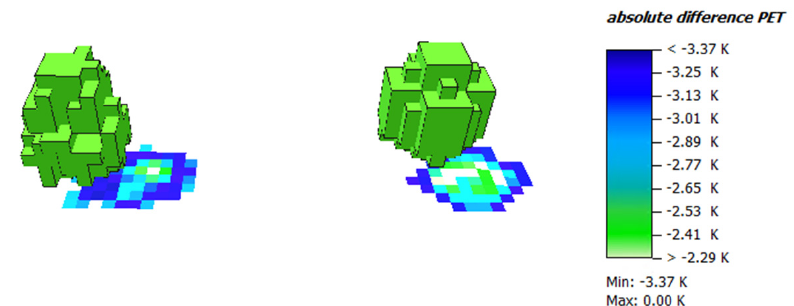
Figure 11. Absolute difference in physiological equivalent temperature (PET) at 1.4 m height level at noon below L-Tree ( left ) and Parametric-Trees ( right ) between ACRT on and ACRT off simulations. Negative values indicate lower PET values in the ACRT on simulation.